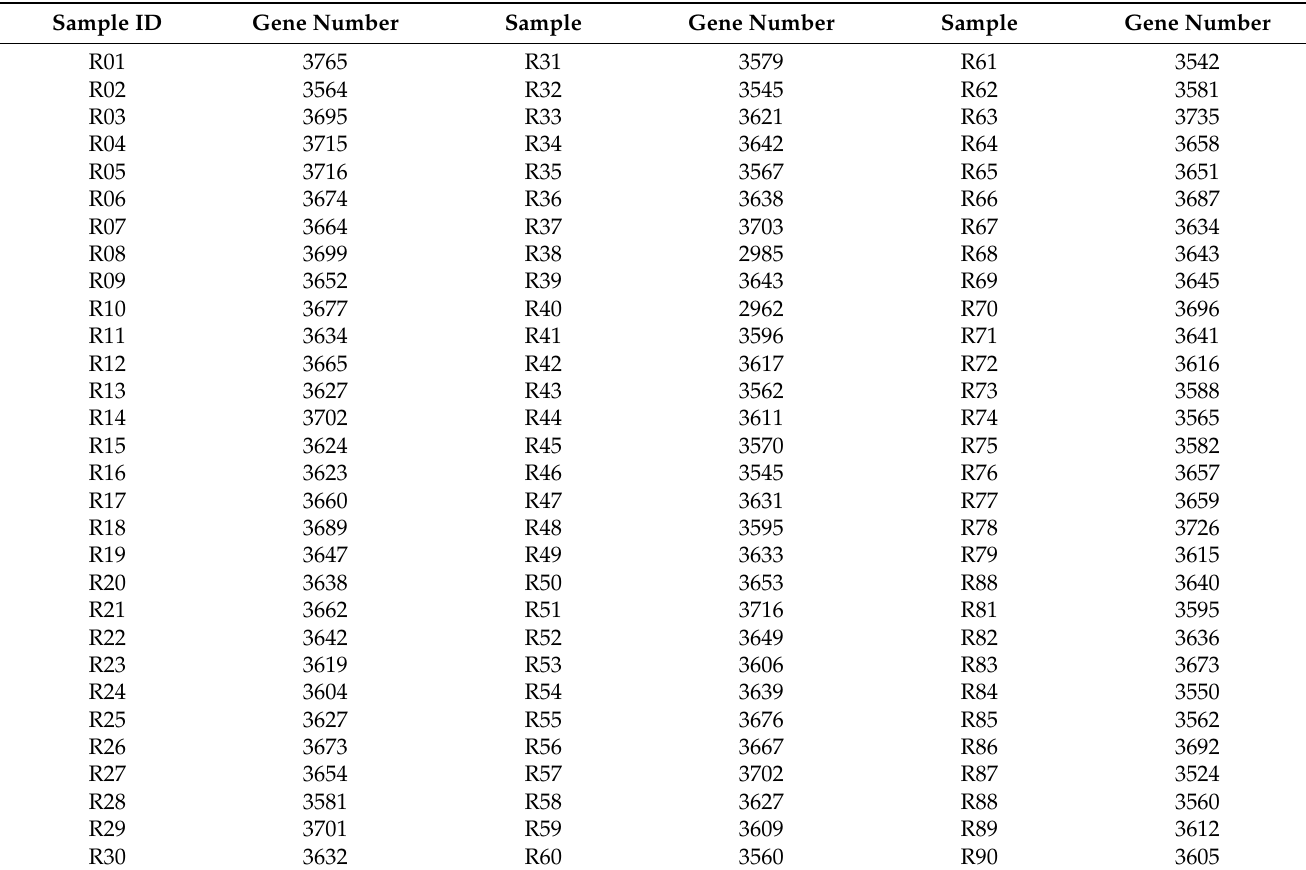
Table A4. Statistical results of variant genes after annotation of 90 individual samples in A. c. cerana